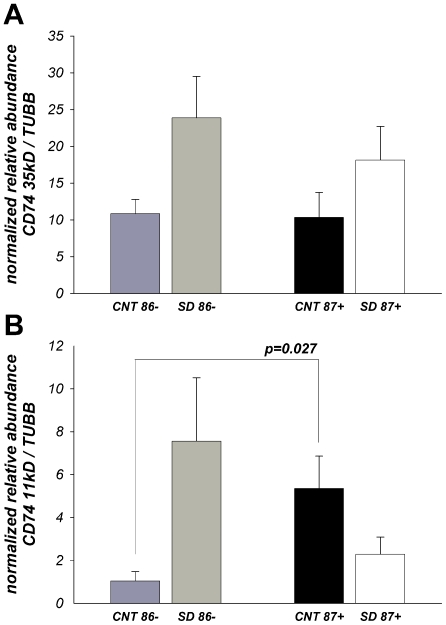
Relative abundance of CD74 -35/33kD (A) and -11kD (B) proteins in the inferior temporal cortex –BA20 of patients with SD (CDR4–5) and cognitively normal (CDR0) individuals.Protein levels of CD74 were measured by Western Blot (Suppl. Fig. 4). Data expressed as means ± SEM of ODs normalized to the generic sample – “calibrator” and endogenous control - TUBB protein (N = 9–10/group, see Table 1).